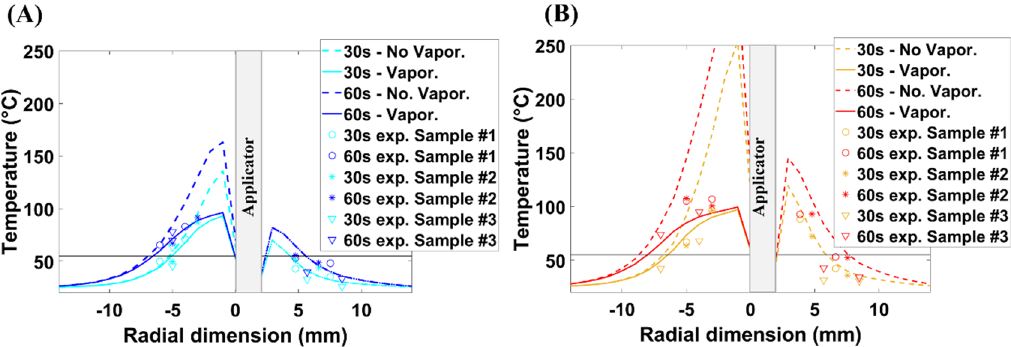
Figure 7. Numerical and experimental values of temperature along the radial distance from the MW antenna axis (applicator) both in the fat and the adrenal gland at 30 s and 60 s for 30 W ( A ) and 60 W ( B ). Numerical values include the temperature obtained using the standard BHE (dot lines) and the BHE modified to account for the effect of water vaporization (solid lines). Horizontal line highlights the temperature threshold at 55 °C.